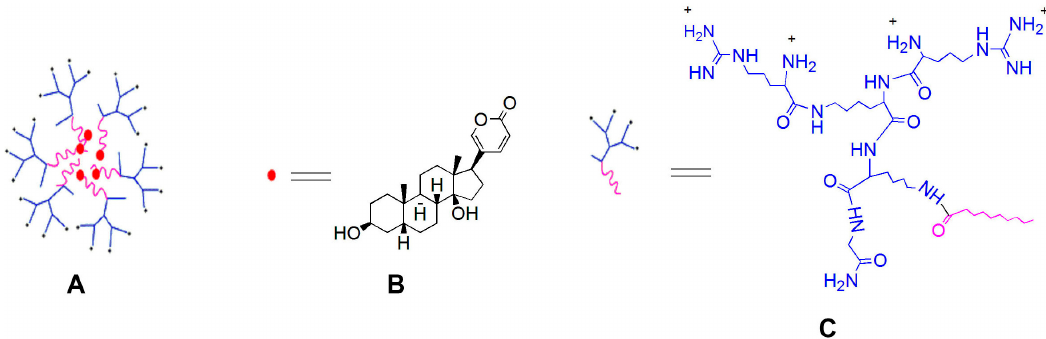
Figure 1. Molecular structure of bufalin-peptide-dendrimer inclusion ( A ); bufalin ( B ) and peptide- dendrimer ( C ).